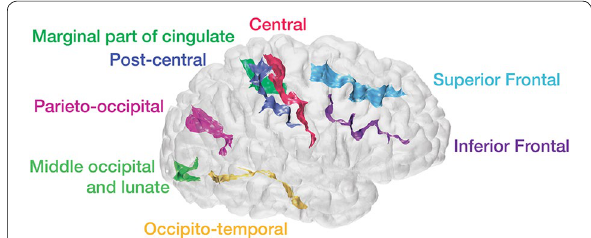
Fig. 3 Example cortical surface with estimated sulci identified and